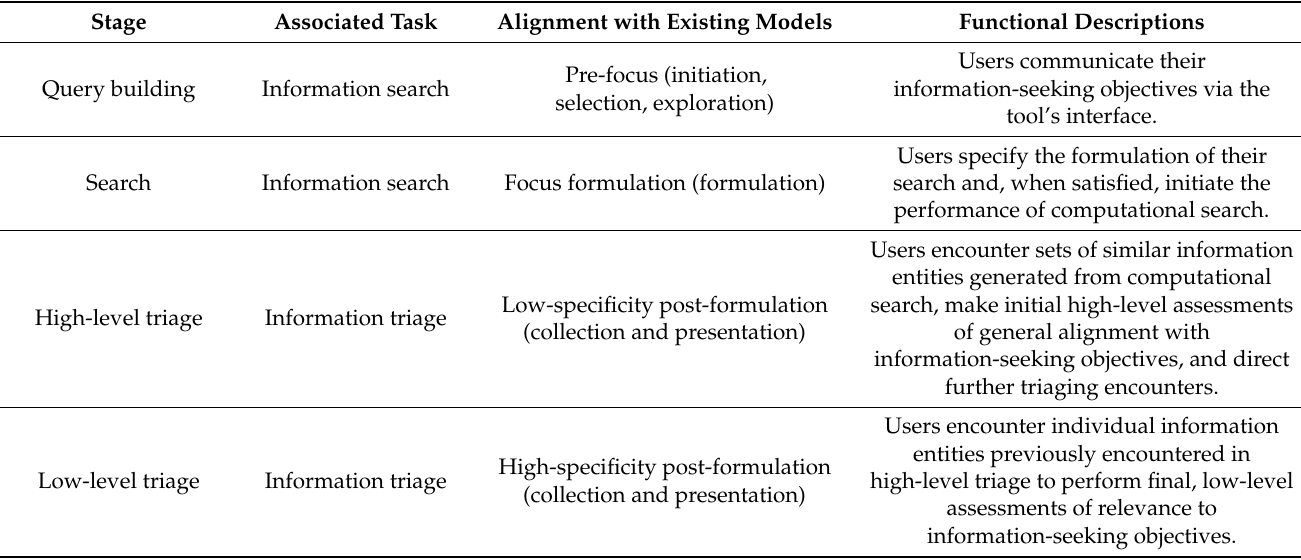
Table 2. The stages of the information-seeking and triage process: their associated task, alignment with existing models, and functional